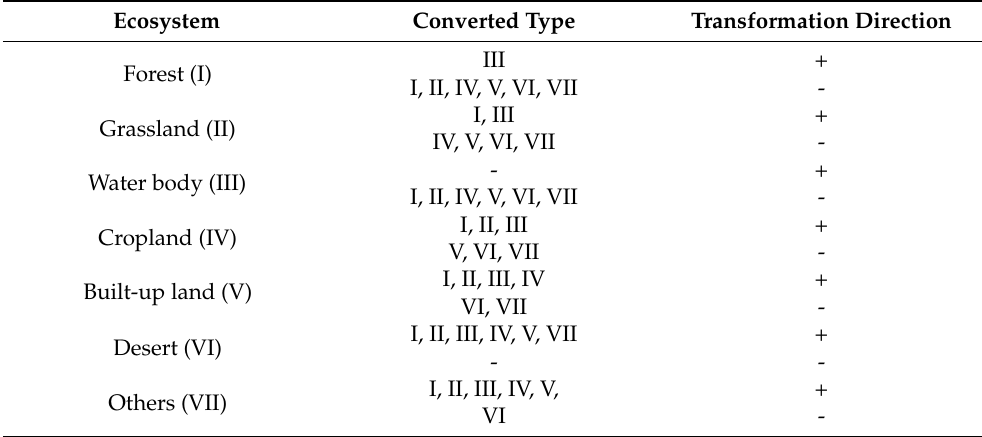
Table 4. Rules of forwarding/reverse ecosystem transformation.